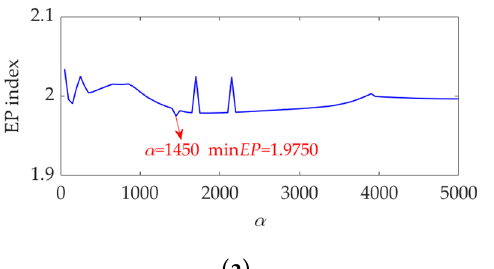
14 of 23 Figure 11. Vibration dataset associated with the inner race fault: ( a ) time − domain waveform and ( b ) SES. To find an optimal value for the balancing parameter α of SVMD, the α value was set to increase from 50 to 5000 at a step size of 50. In each step of α increase, SVMD was first implemented with the current α value for this vibration dataset to obtain a number of modes, then the EP index of each mode was calculated according to Equation (16), and finally the mode indicated by the minimum EP value was considered as the target mode corresponding to current step. When the α value increased to 5000 and the last target mode was achieved, the relationship curves between the α value and the EP index and order number of the target mode in each step were plotted, as shown in Figure 12. It can be seen that, when the α value is 1450, the EP index achieves an global minimum value, and the corresponding target mode is the ninth mode. Hence, we set the optimal value for the balancing parameter α of SVMD to be α opt = 1450 and applied the SVMD algorithm to decompose the vibration dataset in this case. The decomposition results are shown in Figure 13. The variation curve of the EP index for each mode is shown in Fig- ure 14. It can be seen that the ninth mode has the minimum value of the EP index, and it was thus chosen as the optimal target mode, which is consistent with the result in Figure 12b. The optimal target mode containing the complete fault information about the inner race is shown with details in Figure 15a, and its SES is shown in Figure 15b. It can be seen that the actual extracted FCF is 156 Hz, which closely matches the theoretical FCF of the inner race, i.e., 155.3260 Hz, and other frequency components acting as interfer-